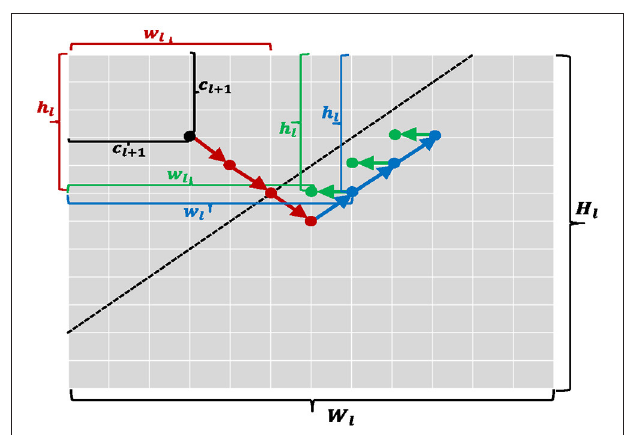
FIGURE 7 | A graphical description for Algorithms 1 and 2 . A step-by-step grid search is performed and arrows with different colors denote different search directions. Each of colored dots is a candidate item of parameter